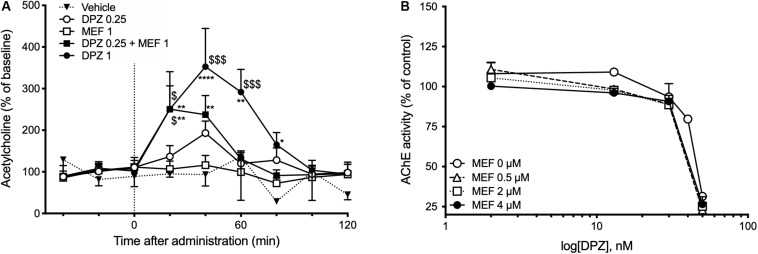
Effects of mefloquine (MEF) on donepezil-induced acetylcholine outflow (A) or donepezil (DPZ)-induced inhibition of acetylcholinesterase (AChE) activity (B). (A) Acetylcholine (ACh) levels in 20-min collected microdialysate samples are expressed as percentages of the basal level calculated as the mean value of the three samples collected prior to administrations of MEF (1 mg/kg, i.p.), DPZ (0.25; 1 mg/kg, i.p.), or vehicle (NaCl 0.9%). Values are expressed as means ± SEM, n = 4–7 per group. Two-way ANOVA followed by Fisher least significant difference: *P < 0.05, **P < 0.01 vs Vehicle; $P < 0.05, $$$P < 0.001 vs DPZ0.25. (B) Concentration-dependent inhibition by DPZ (0, 2, 13, 30, 40, and 50 nM), in the absence or presence of MEF (0.5–4 μM), of mouse hippocampus AChE activity. Acetylcholinesterase activity is expressed as percent of that determined in the absence of drugs. Each data point represents the mean ± SEM of triplicate determinations in two independent experiments.